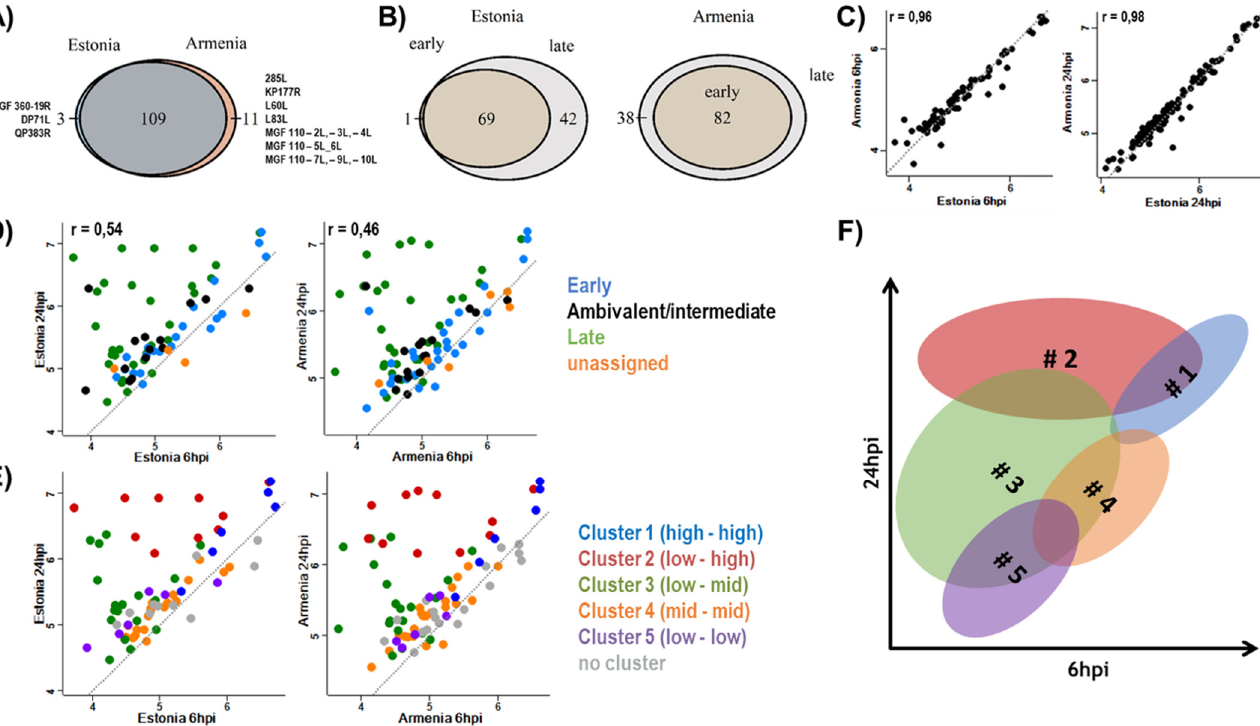
Figure 2. Expression of viral proteins after infection of monocyte-derived macrophages (moM Φ ) with African swine fever virus (ASFV) strains Armenia 2008 or Estonia 2014. ( A ) Qualitative comparison of the expression of viral genes in infected moM Φ after infection with Armenia 2008 or Estonia 2014. ( B ) Comparison of ASFV proteins expressed at early (6 hpi) and late (24 hpi) time points after infection with Estonia 2014 (left) or Armenia 2008 (right). ( C ) Correlation analysis of the expression levels of viral proteins after infection with Armenia 2008 or Estonia 2014 at 6 hpi (left) and 24 hpi (right), based on log10 LFQ (label-free quantitation) values. ( D , E ) Comparison of ASFV protein expression at early (6 hpi, x-axes) and late (24 hpi, y-axes) stages after infection with Estonia 2014 ( left ) and Armenia 2008 (right). Colours represent published kinetic classes ( D ) or recently proposed revised temporal clusters [12] ( E ). ( F ) Schematic summary of temporal expression clusters based on Cackett et al. (2022) [12]. ( C – E ): Quantitative data are based on means of log 10 -transformed label-free quantification values representing 6 replicates per condition, r = Pearson’s correlation coefficient, grey dotted line = dissecting line as reference.